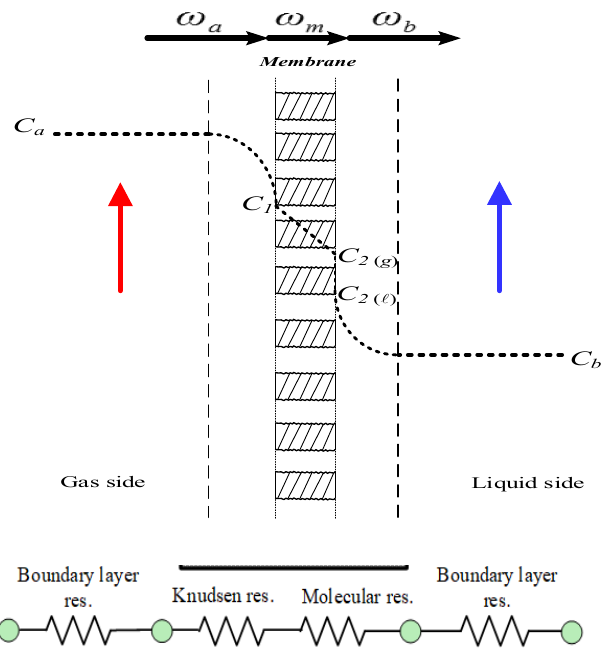
Figure 4. Schematic diagram of mass-transfer resistances and CO 2 concentration variations in a gas- liquid membrane contactor. gas-liquid membrane